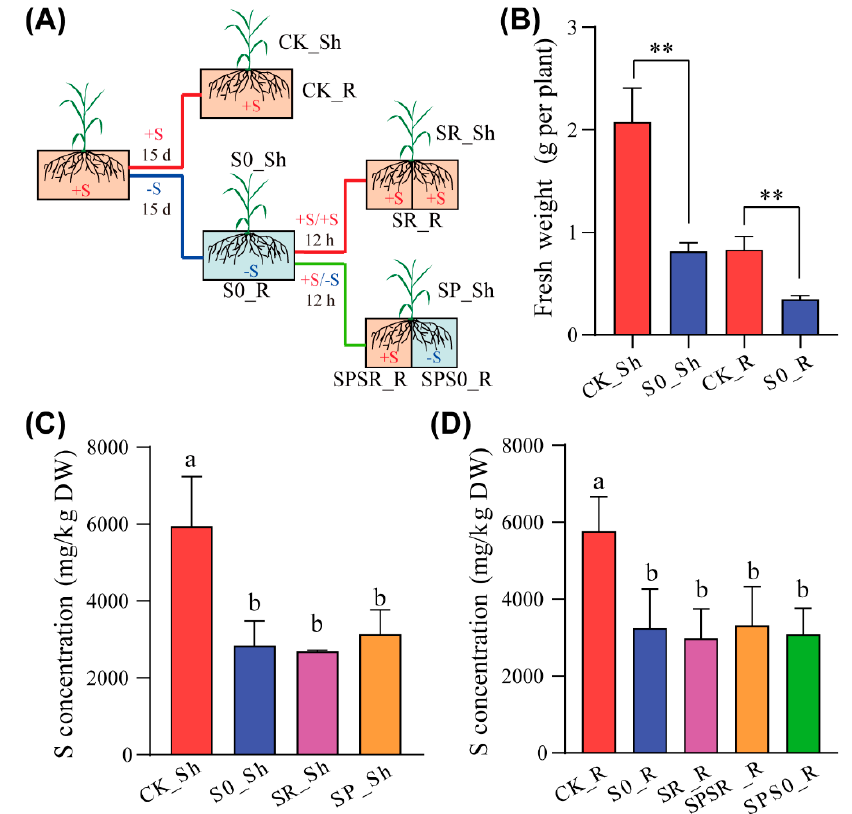
Figure 1. Experimental design and total S concentrations in plants. ( A ) Schematic diagram of experimental design. Plants grown with sufficient sulfate (0.45 mM SO 42 − ) to five-leaf stage were subjected to sulfate deficient treatment (0 mM SO 42 − ; S0) for 15 d or continued growing with sufficient sulfate as control (CK). The roots of sulfate deficient treated plants were equally split into two halves and then resupplied with 0.45 mM SO 42 − for 12 h in both split-root halves (SR), or only one split-root halve (SPSR) with the other root half remained in sulfate deficiency (SPS0). ( B ) The fresh weight of roots and shoots of seedling subjected to sulfate deficient treatment for 15 d. ( C , D ) Total S concentrations in shoots ( C ) and roots ( D ) of plants resupplied with 0.45 mM SO 42 − for 12 h in both split-root halves or one split-root halve only. Data in ( B – D ) are presented as means ± SD with three biological replicates. ** in ( B ) represents significant differences at p < 0.01 (Students’ t -test). Columns with different letters in ( C , D ) indicate significant difference at p < 0.05 (Tukey-Kramer Test). DW, dry weight.